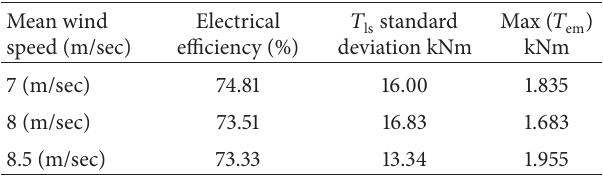
Table 3: TSMC performance for different wind speed profiles.